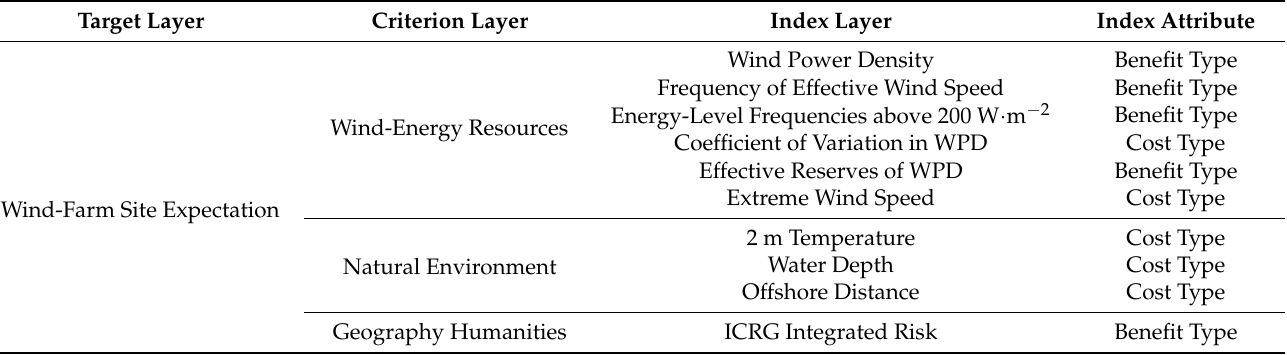
Table 2. Integrated risk assessment system.